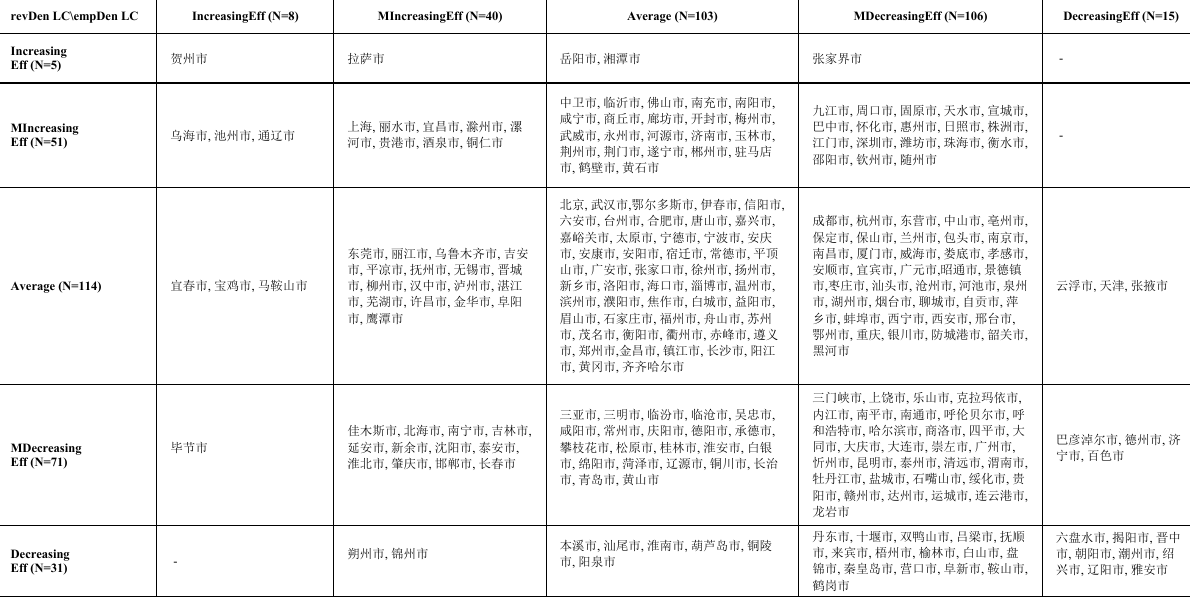
Table B. Class membership matrix of Model 2a and Model 2b (Rows are latent classes based on Model 2a, revenue Density; Columns are latent classes based on Model 2b, employment Density; Name of cities in